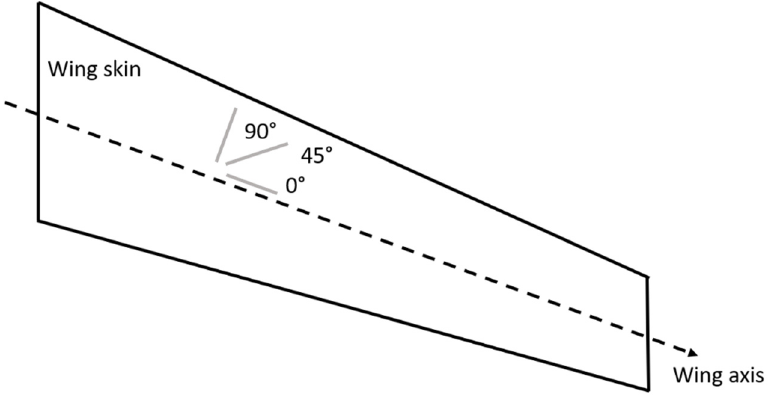
Figure 9. FBG layout of strain sensing rosettes